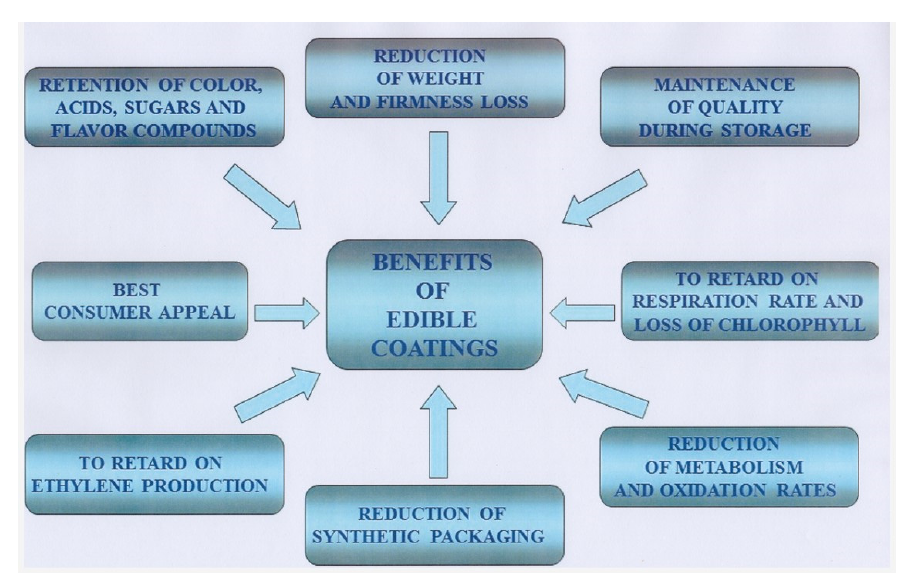
Figure 1. Main benefits of edible